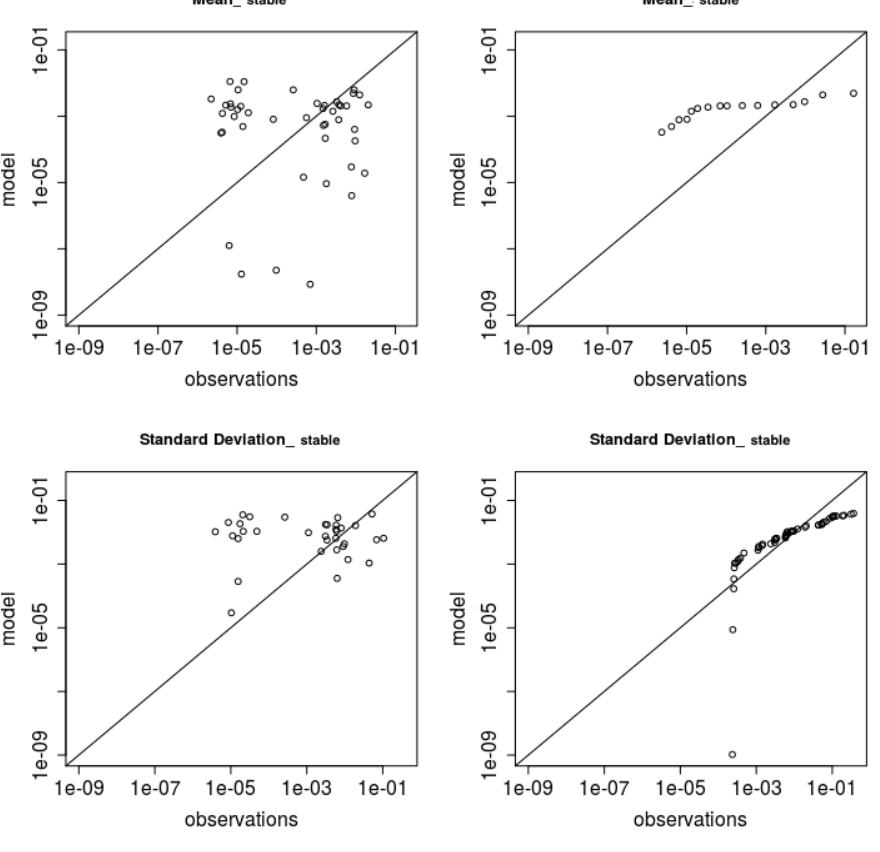
Figure 2. Scatter-plot ( left ) and qq-plot ( right ) for stable condition trials (g m − 3 ). Neutral Condition